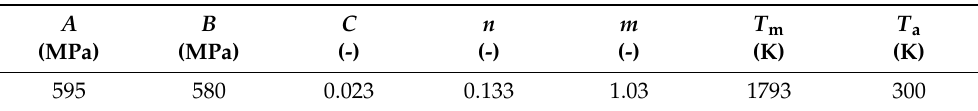
Table 2. Input data for the Johnson–Cook constitutive equation to model the plasticity behavior of DIN 42CrMo4 based on [9,16].